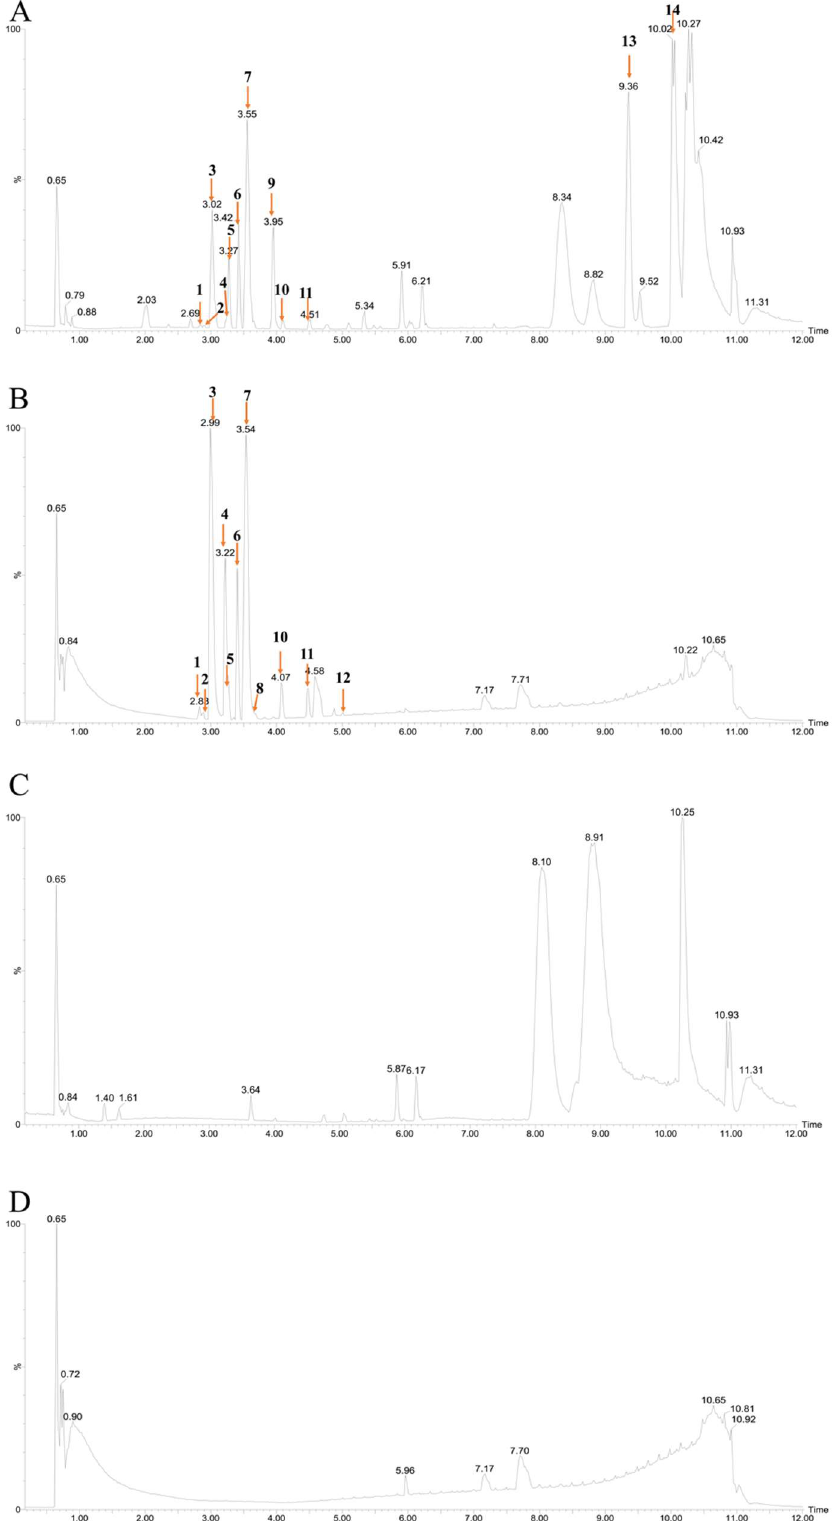
Figure 3. Identification of chemical constituents from E. acoroides aqueous extracts in ( A ) positive ionization mode; ( B ) negative ionization mode; identification of chemical constituents from sterilized artificial seawater in ( C ) positive ionization mode; ( D ) negative ionization mode. Numbers above peaks represent retention times, in minutes.